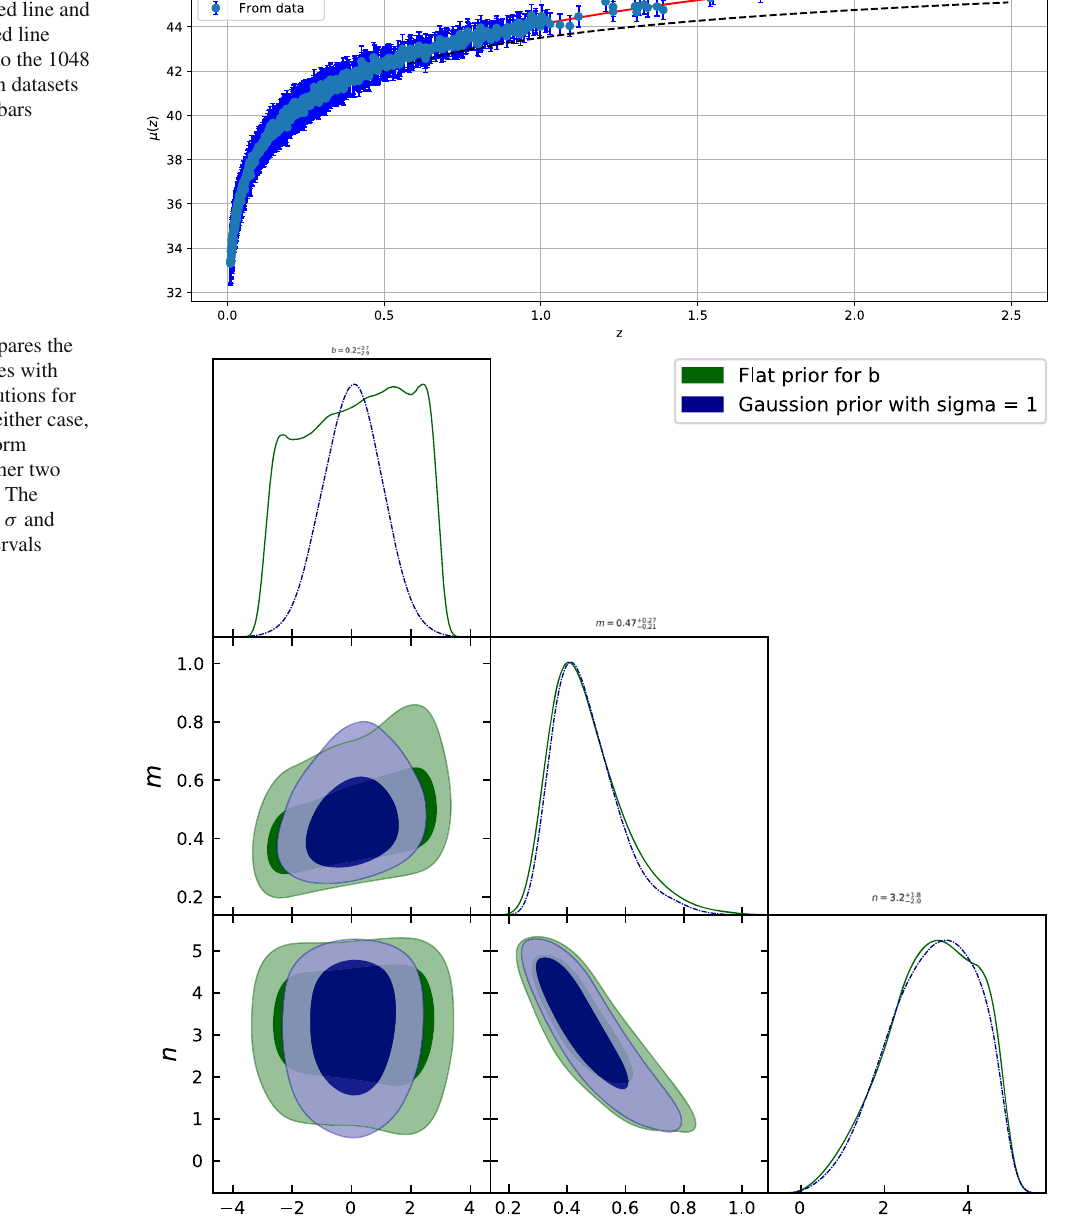
Fig. 2 The plot compares the two numerical analyses with different prior distributions for the parameter b . For either case, we considered a uniform distribution for the other two parameters, m , and n . The counter represent 1 − σ and 2 − σ confidence